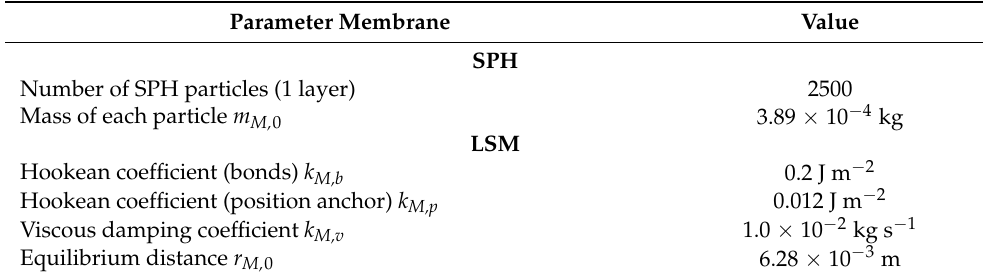
Table 1. Model parameter of the Membrane.